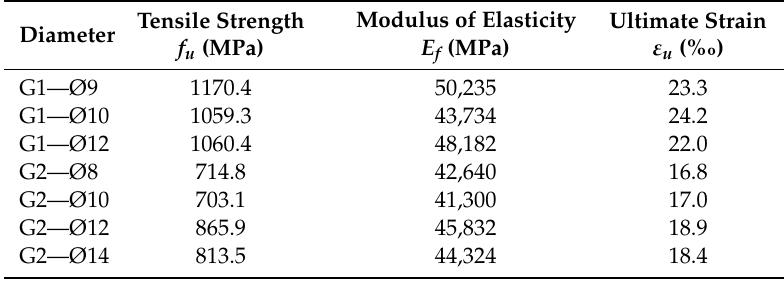
Table 2. Mechanical and deformation properties of GFRP bars.